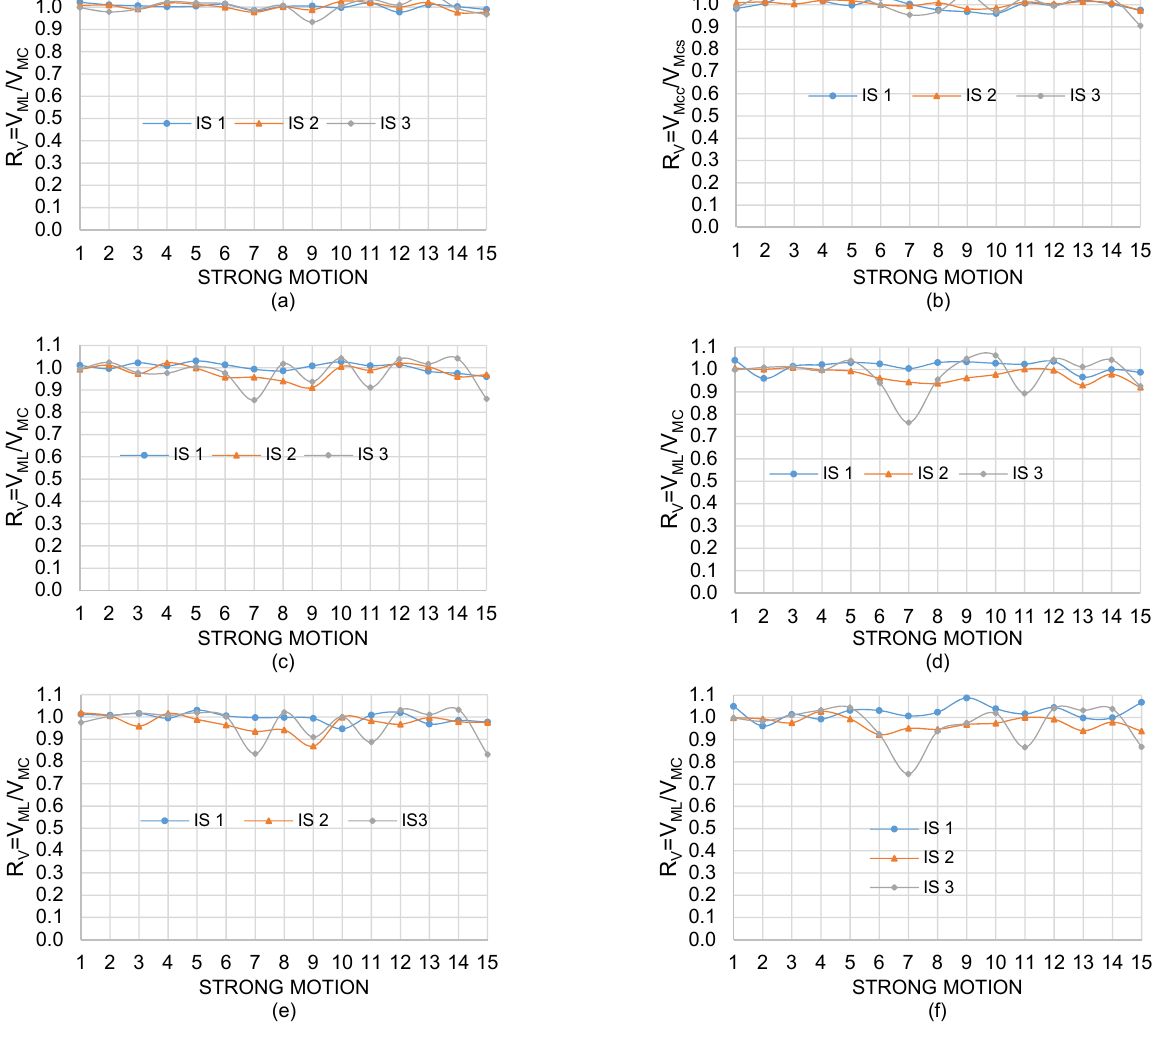
Figure 6. Values of R V ; Model 1; ( a , c , e ), Sa avg = 0.2, 0.6, 0.8 g, respectively, NS direction; ( b , d , f ), Sa avg = 0.2, 0.6, 0.8 g, respectively, EW direction.